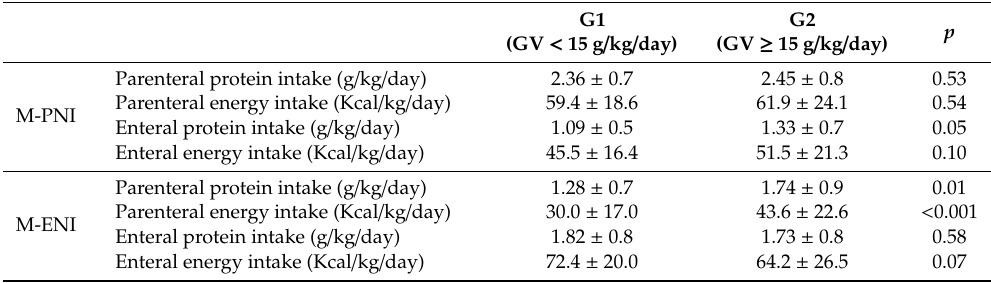
Table 3. Nutritional intakes during the transition phase (TP) from parenteral to enteral nutrition during the mean parenteral nutrition intake period (parenteral nutrition intake > 50%; M-PNI) and during the mean enteral nutrition intake period (enteral nutrition intake > 50%;